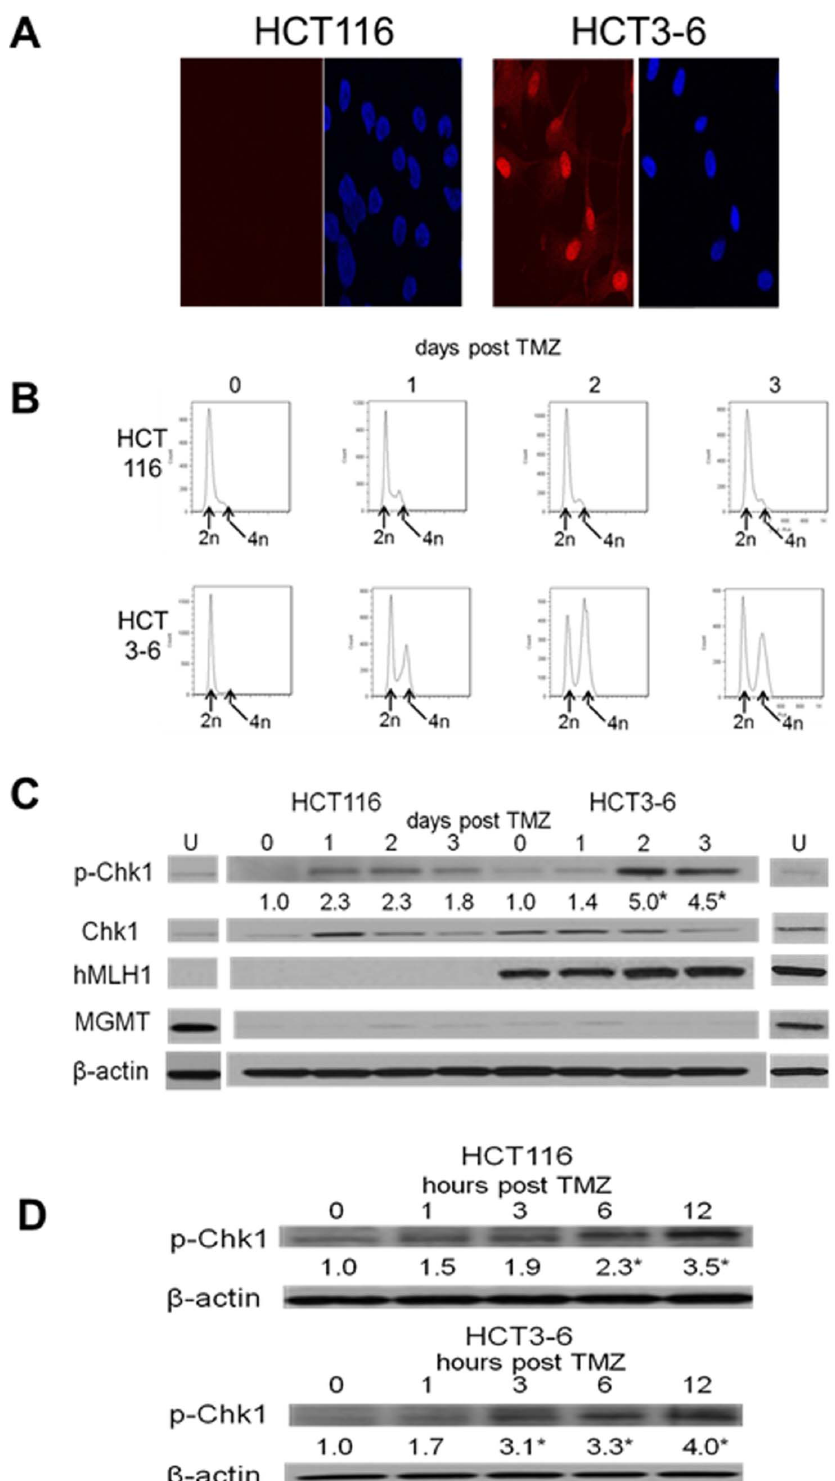
Figure 3. TMZ-induced Chk1 activation is MMR-independent. Isogenically paired HCT cells differing only in MMR capabilities (MMR-deficient HCT116 and MMR-proficient HCT3-6) depleted of MGMT by pre-incubation with BG (20 m M, 2 hrs, G55 + BG) were incubated with vehicle (U) or TMZ (100 m mol/L, 3 hours) after which TMZ was removed, vehicle or BG was replaced, and cells were harvested at 24–72 hours (A, C) or at earlier time points (1–24 hours, B, D) following TMZ exposure for analysis of H2AX foci (A, DAPI staining in right panel of pairs), DNA content by FACS (B), or pChk1, Chk1, hMLH1, MGMT, and b -actin expression by Western blot (C, D). Mean fold induction of protein expression was based on densitometric measurements and is shown (relative to untreated controls) below the relevant immunoreactive bands. *, p , .05.